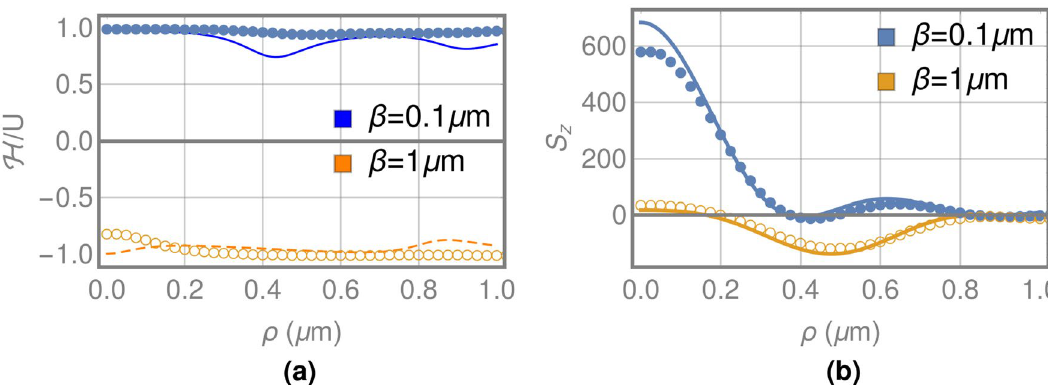
Figure 4. ( a ) Local density ratio of helicity in the focal plane for a SGFZP (continuous line and filled circles) and a LGFZP (dashed line and unfilled circles) with focal length of 7 (cid:31) estimated through the proposed model (lines) and FDTD (circles). ( b ) Axial component of the SAM in the focal plane for a SGFZP (continuous line and filled circles) and a LGFZP (dashed line and unfilled circles) with focal length of 7 (cid:31) estimated through the proposed model (lines) and FDTD (circles).